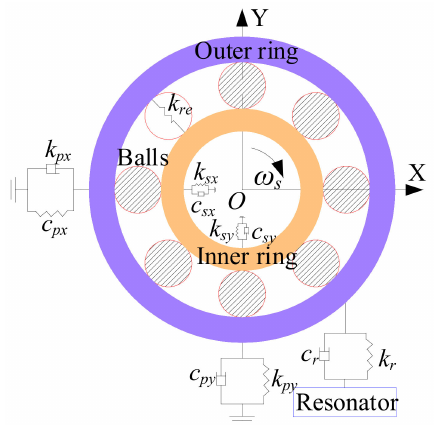
Figure 2. Model of the supporting ball